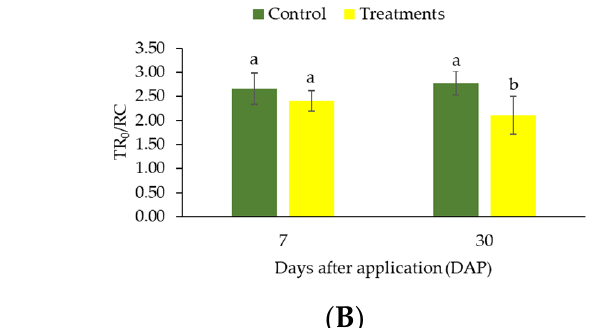
Figure 2. Changes in the ratios ABS/RC ( A ) and TR 0 /RC ( B ) in co ff ee leaves (genotype “153”) sub- mi tt ed to high light after application of CC. The measurements were made after 7 and 30 days of treatment. Before the measurements, leaves were dark-adapted for 30 min. Values are averages for eight plants. The data shows mean value ± standard errors. Means followed by di ff erent lowercase le tt ers in each sampling (7 and 30 days) di ff er by Tukey’s test, at 5% probability. In this study, RC/CS 0 values were similar ( p > 0.05) after 7 days of treatment (Figure 3). However, at 30 days, the sunscreen-treated plants presented higher RC/CS 0 values com- pared to control plants ( p ≤ 0.05) (Figure 3).